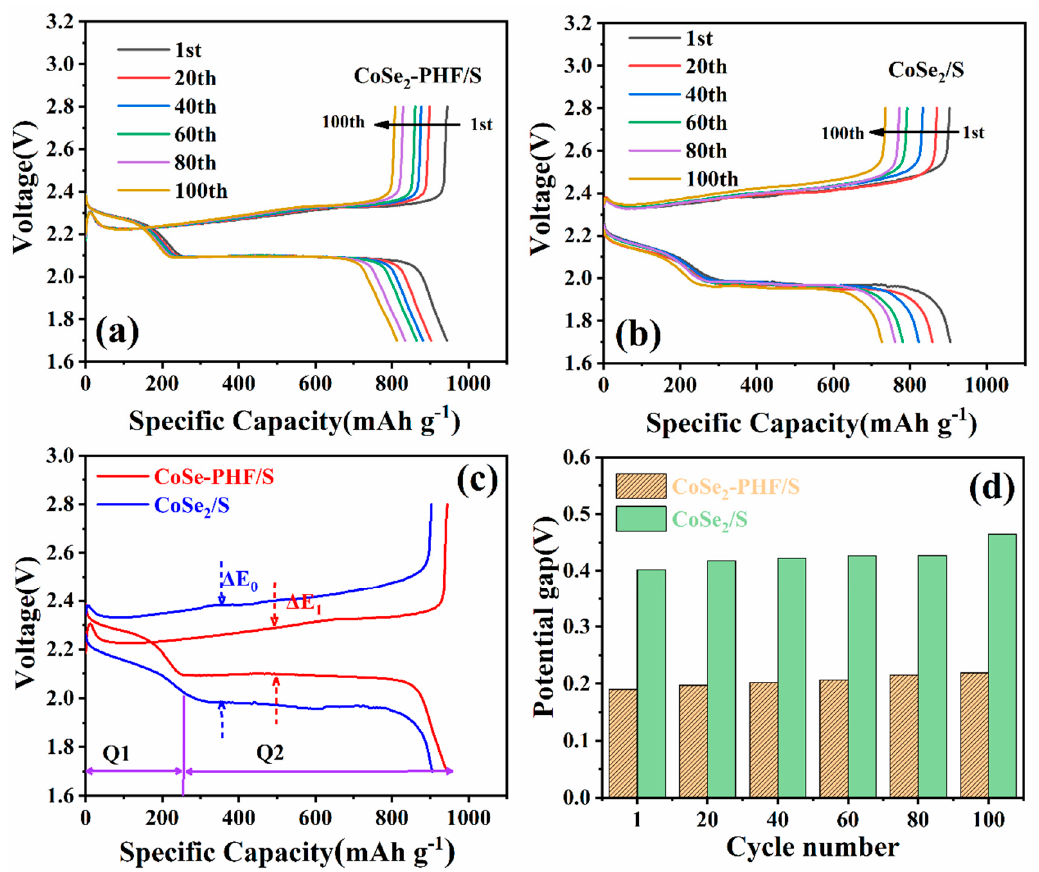
Figure 7. Charge − discharge cycling curves of ( a ) CoSe 2 -PHF/S based and ( b ) CoSe 2 /S based electrodes at a 0.1 C, ( c ) Galvanostatic discharge − charge voltage profiles of the first cycle at 0.1 C, ( d ) potential gap of CoSe 2 -PHF/S and CoSe 2 /S electrodes at various charge − discharge cycles.